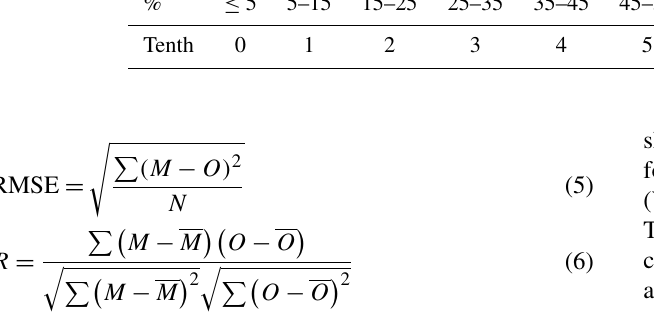
Table 2. ACOS cloud cover (%) to DROM human-eye-observed cloud cover (tenths) conversion table. % ≤